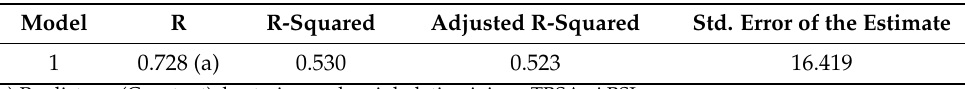
Table A1. Model Summary.